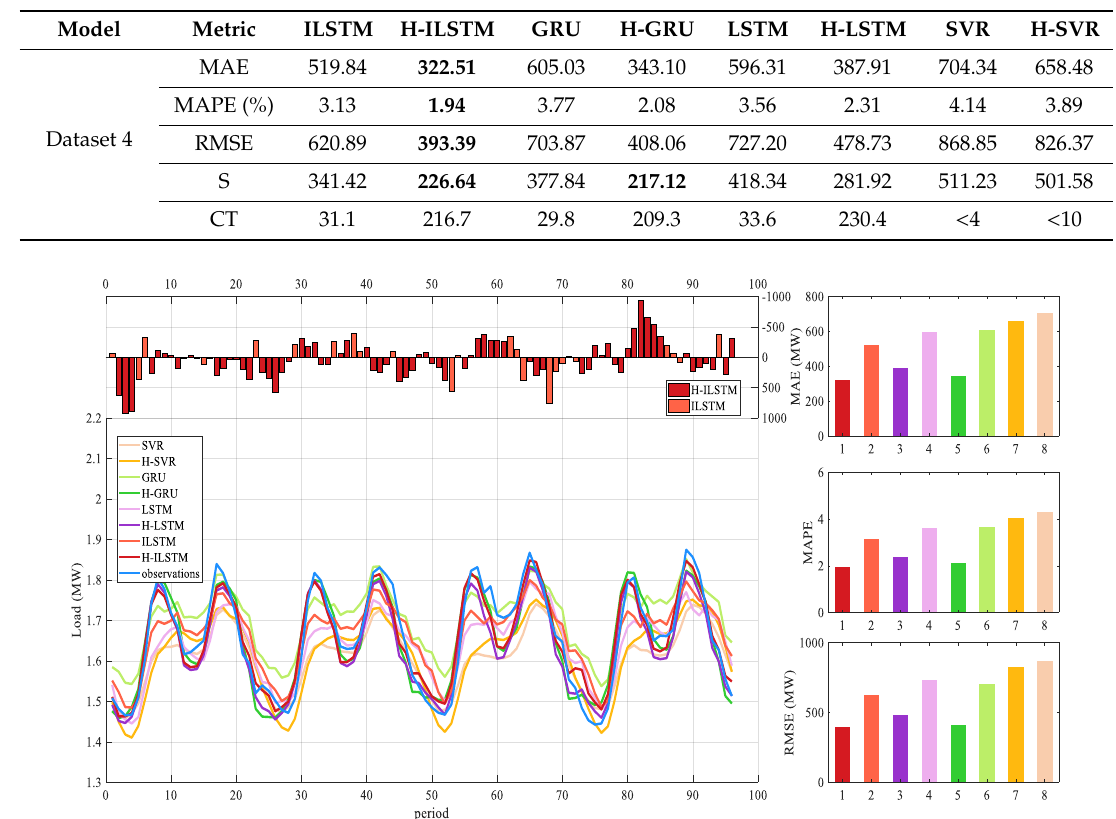
Table 12. The three-step prediction result of the load. (The bold characters in the table represent the